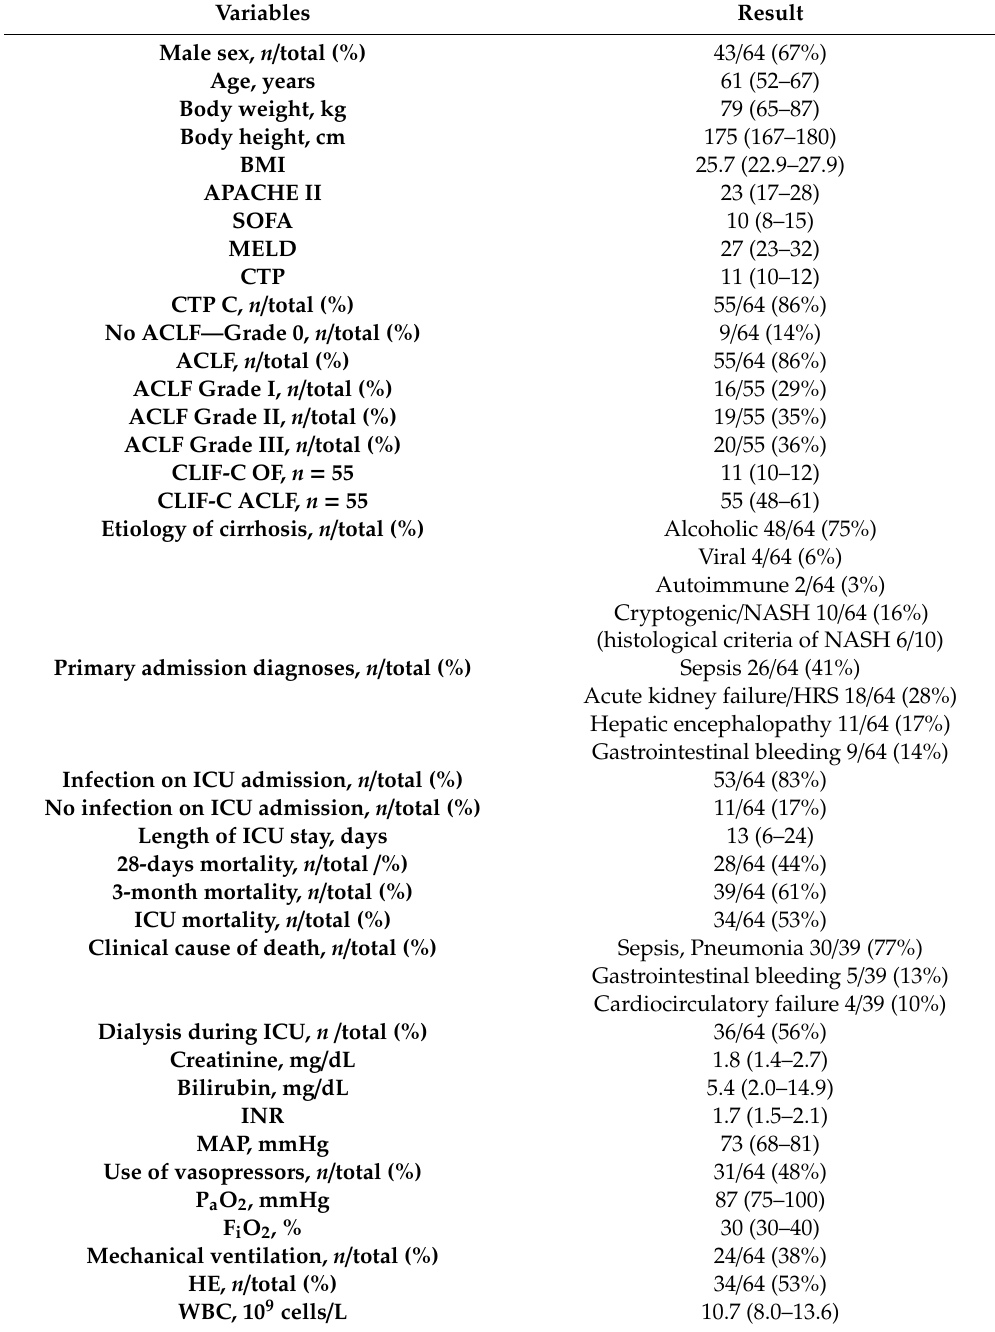
Table 1. Patients’ baseline